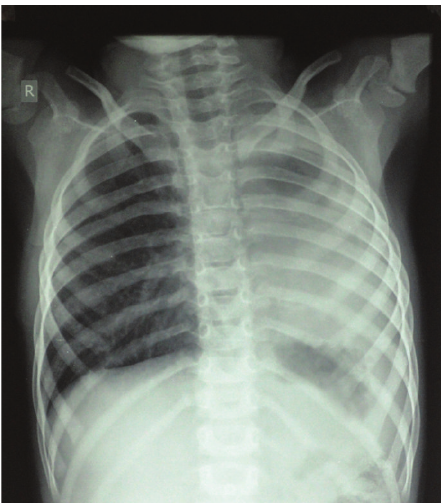
Figure 5: Last followup X ray at 2 years and 7 months showing left lung